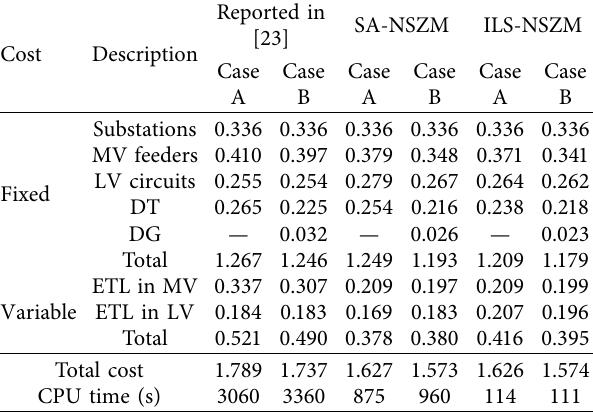
Table 3: Comparison with results reported in [23] in millions of USD, Cases A and B.